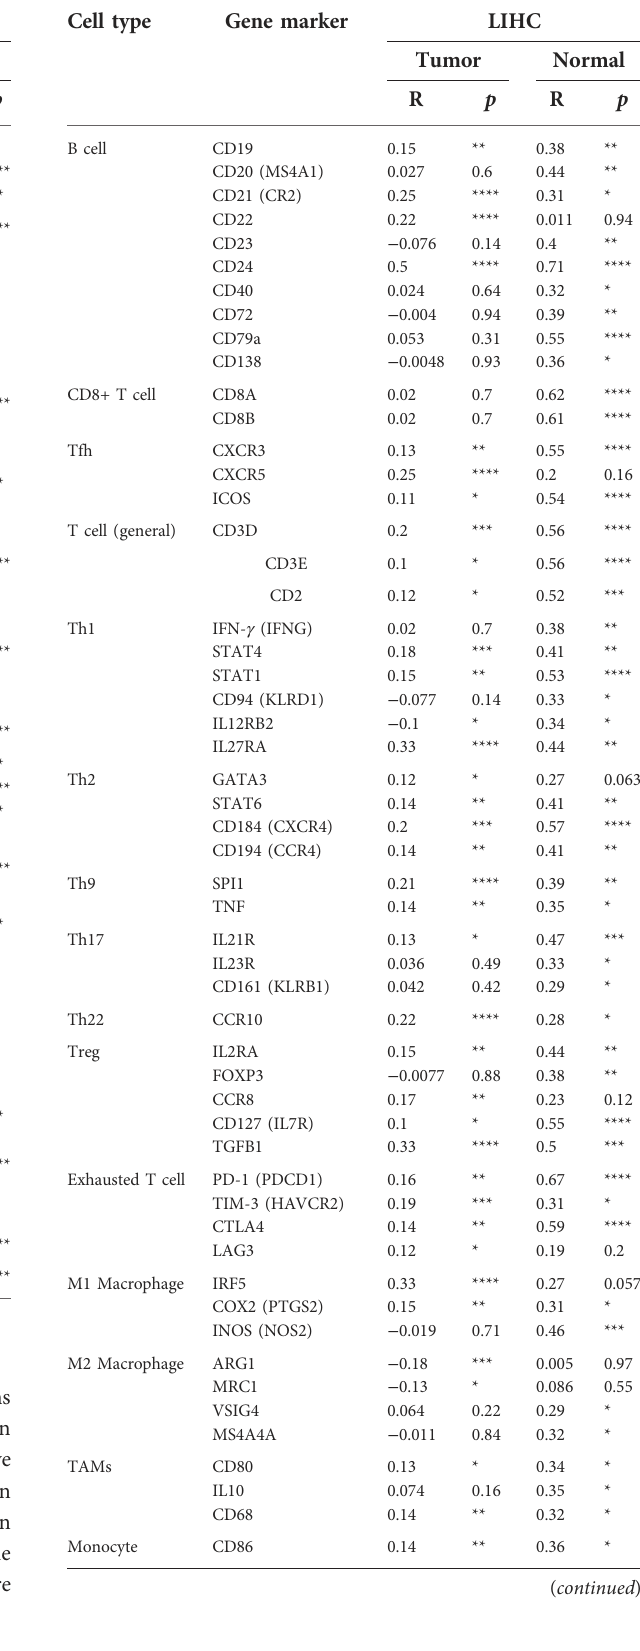
TABLE 4 Correlation analysis between BAIAP2L2 and gene markers of immune cells in GEPIA